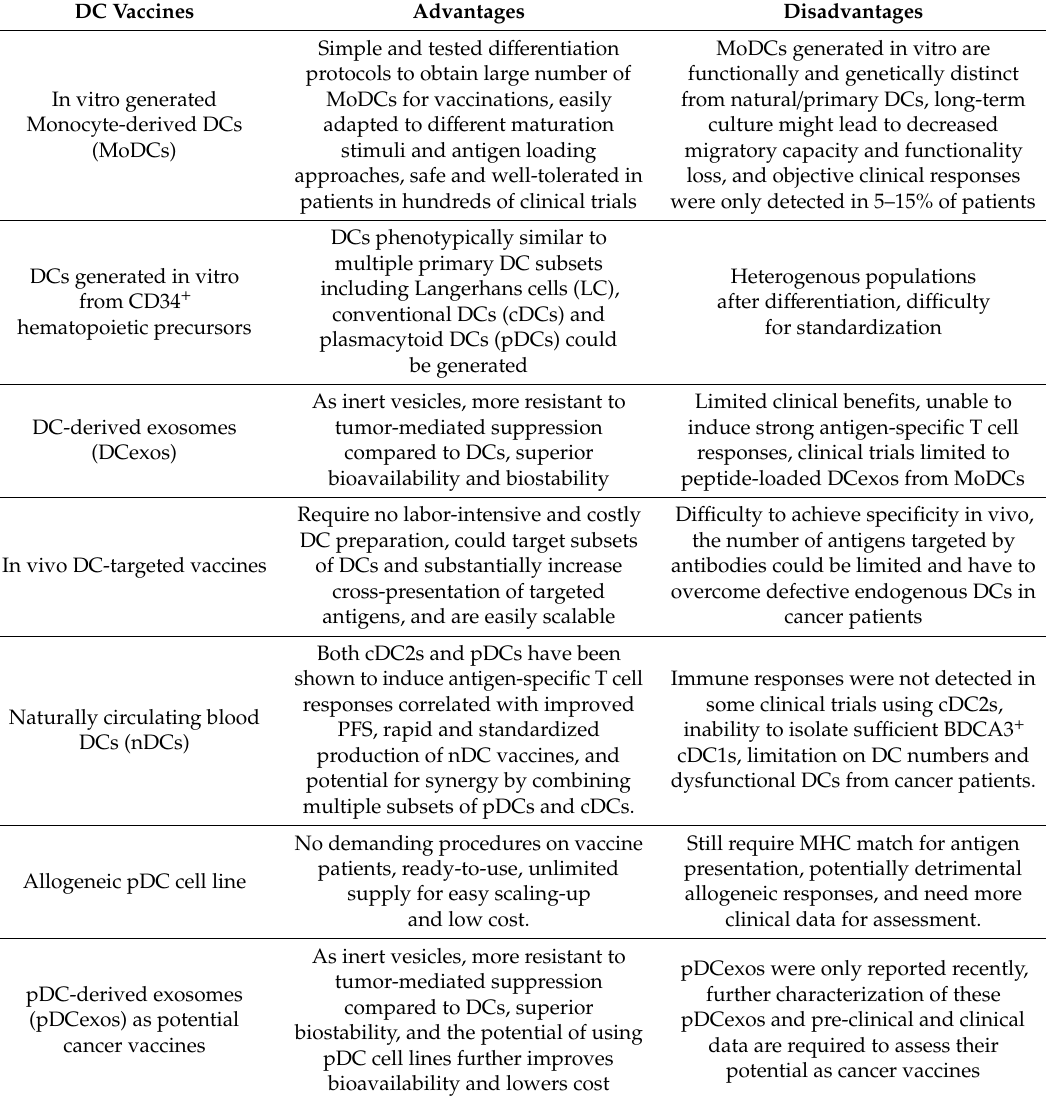
Table 1. Summary of current and potential dendritic cell (DC)-based cancer